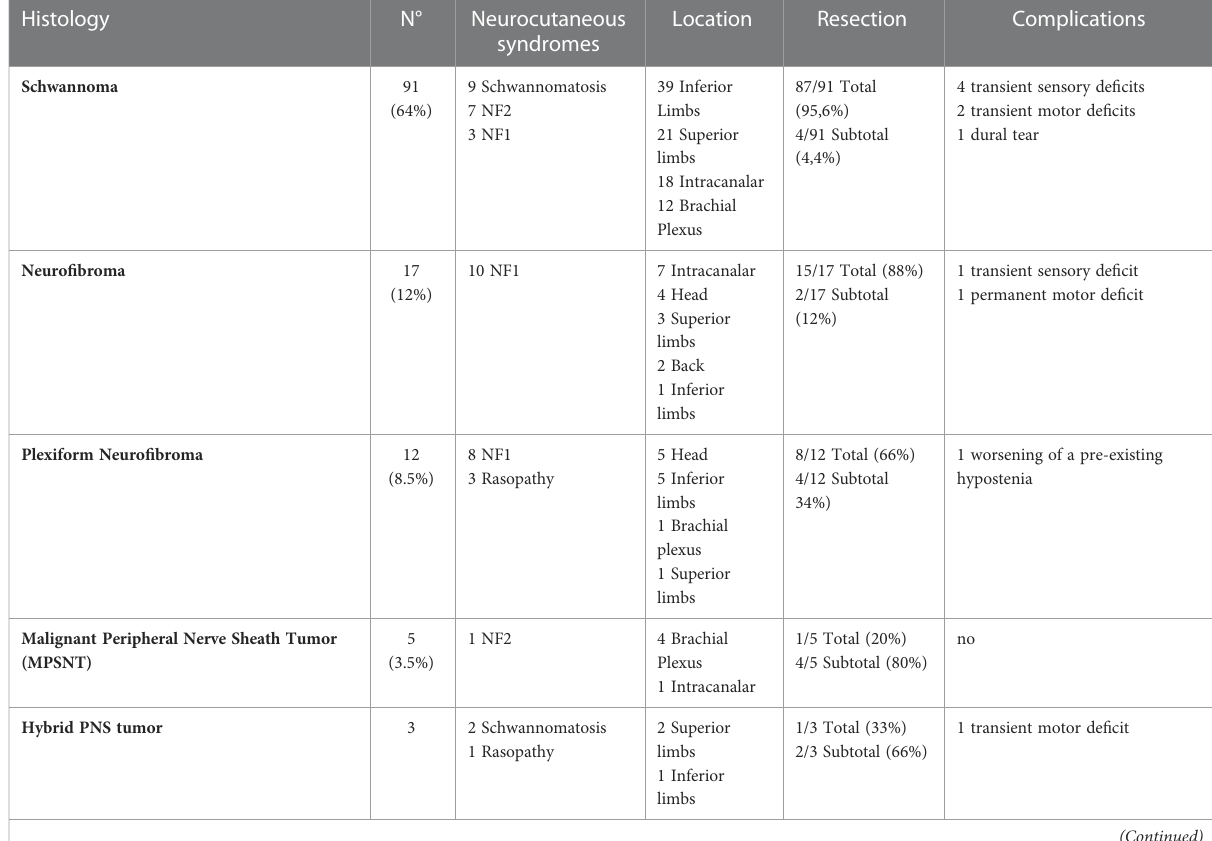
TABLE 1 Clinical characteristics of the Sodium Fluorescein series.